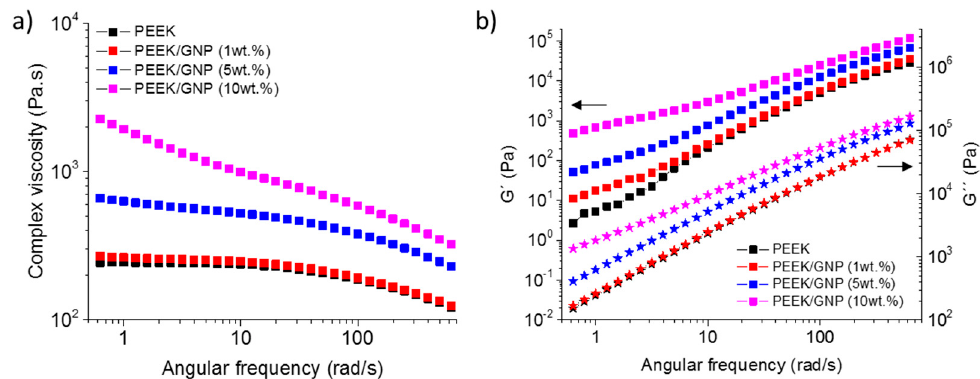
Figure 1. ( a ) Complex viscosity ( η *) and ( b ) square symbols for storage modulus (G ′ ) and star symbols for loss modulus (G ″ ) obtained from dynamic frequency sweep.